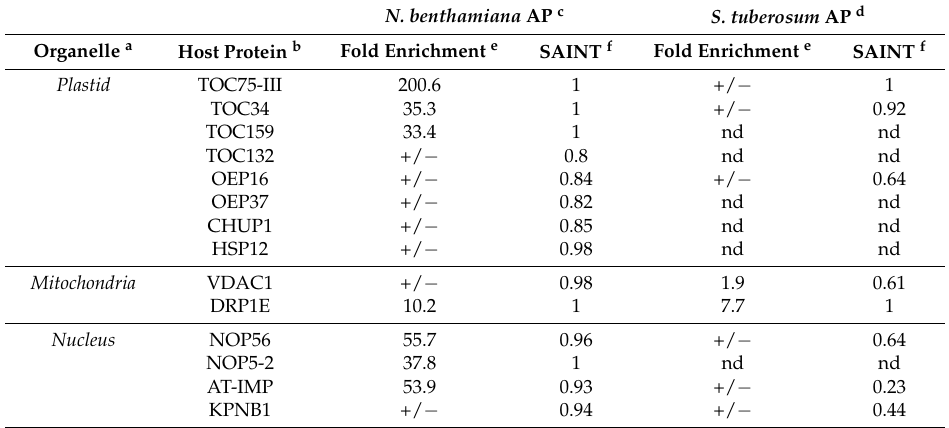
Figure 10. Hypothetical model for the intracellular trafficking of two non-structural viral proteins that regulate long-distance movement of PLRV in plants. Based on imaging results obtained from bimolecular complementation assays coupled to co-localization with fluorescent protein-based organelle markers, P17 (blue circles) and P3a (yellow circles) homo/heterodimer complexes localized to the outer membranes of mitochondria and plastids may traffic to and from plasmodesmata (PD) through plastid stromules, mitochondrial-derived vesicles (MDV), or membrane contact sites (red triangles) established between the cortical endoplasmic reticulum (ER) and other organelles. However, only the P17 movement protein has the ability to permanently associate with PD and the nucleus. Table 1. Proteins identified in the WT PLRV-host interactome that are known to localize to the outer membrane of organelles.